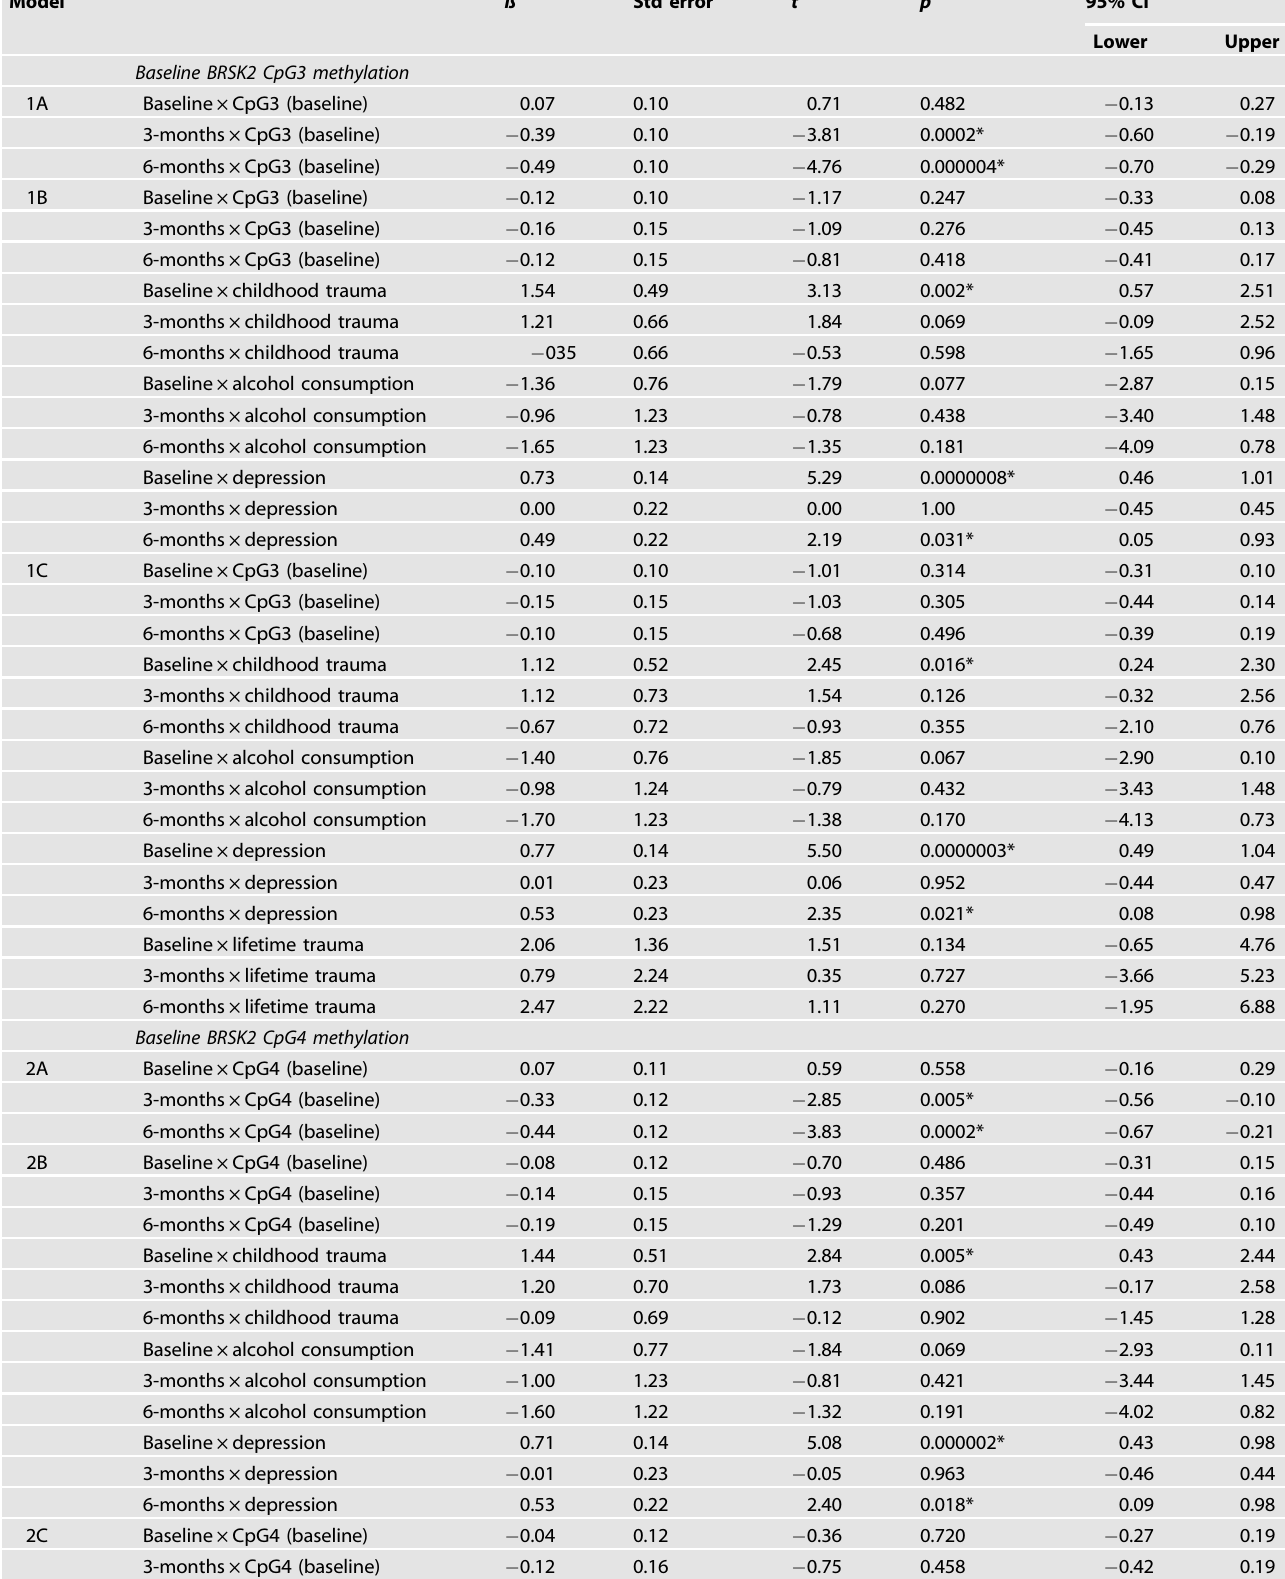
Table 5. Summary statistics of the mixed regression models investigating baseline BRSK2 and ADCYAP1 methylation as predictors of change in posttraumatic stress symptoms scores over